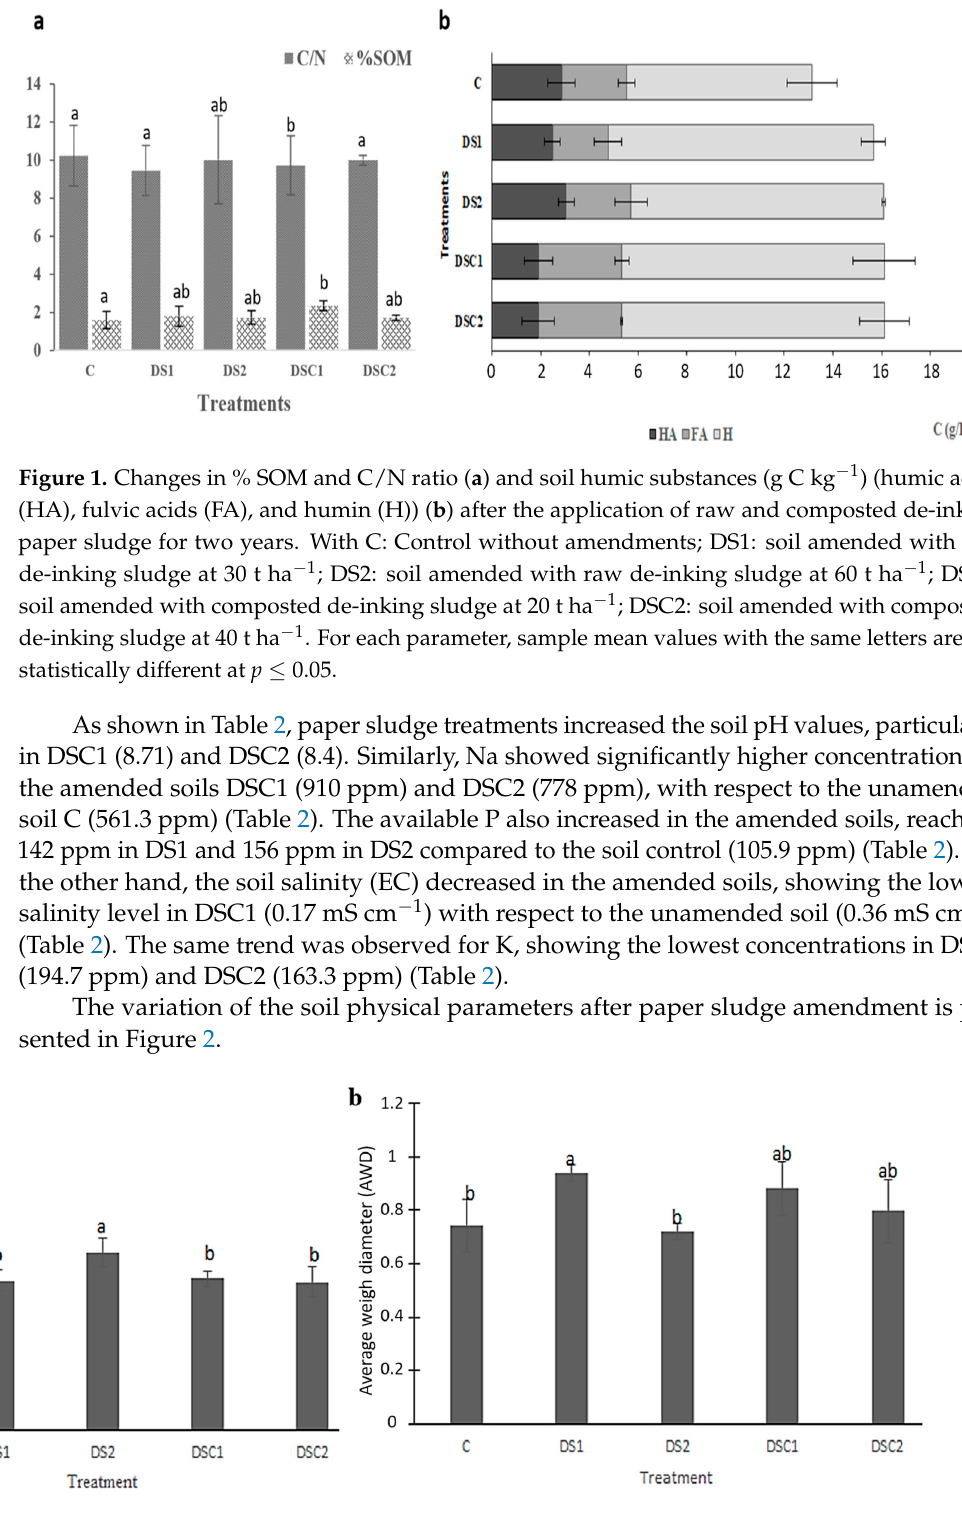
Figure 2. Variation of soil physical parameters (Total porosity ( a ) and the average weigh diameter of aggregates (AWD) ( b )) after the application of raw and composted de-inking paper sludge. C: soil control without amendment; DS1: soil amended with raw de-inking sludge at 30 t ha − 1 ; DS2: soil amended with raw de-inking sludge at 60 t ha − 1 ; DSC1: soil amended with composted de-inking sludge at 20 t ha − 1 ; DSC2: soil amended with composted de-inking sludge at 40 t ha − 1 . For each parameter, sample mean values with the same letters are not statistically different at p ≤ 0.05. The highest porosity was observed in the amended soil DS2 (55%), showing a non-